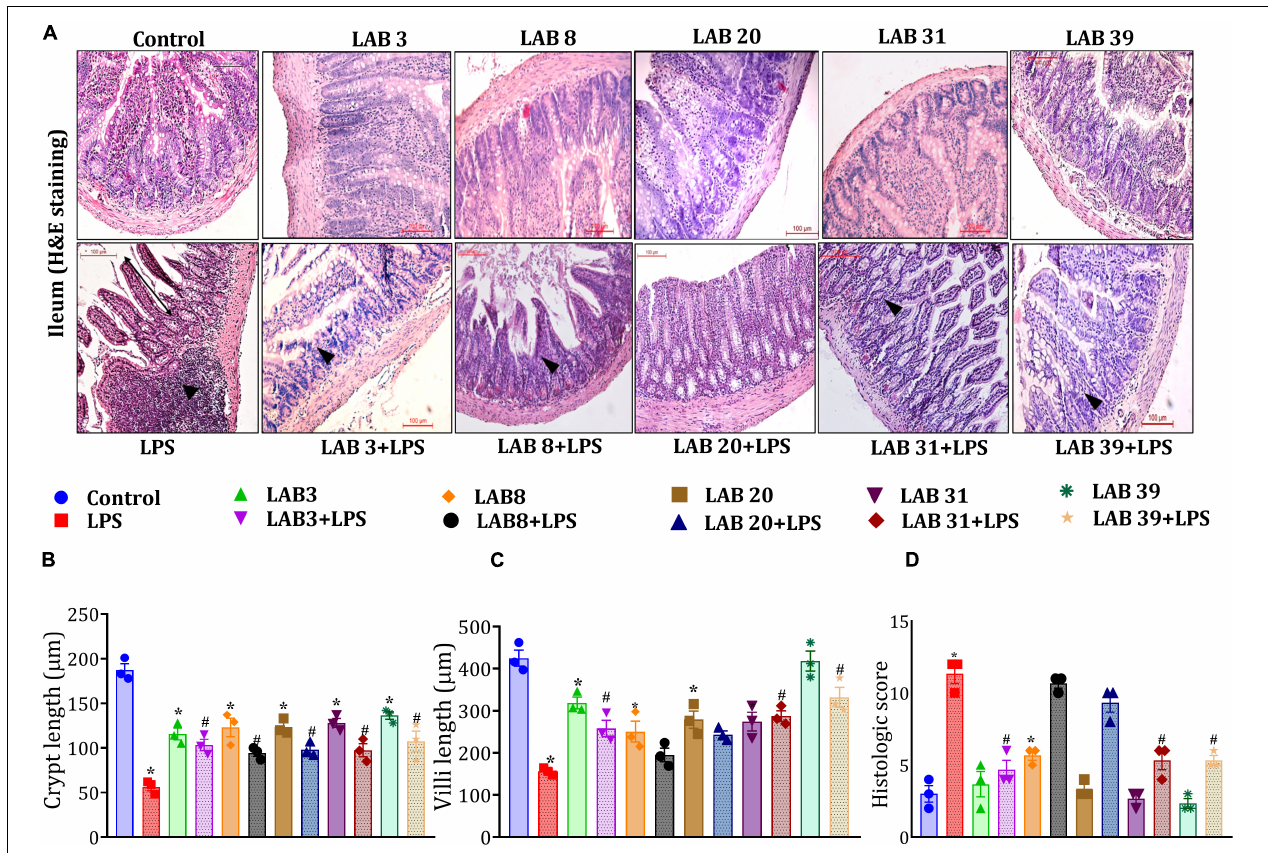
FIGURE 4 | Effect of LAB supplementation on the ileum architecture: (A) Hematoxylin–eosin staining images; (B) crypt length; (C) villi length; and (D) histologic score. Data were analyzed using one-way ANOVA with Tukey’s post hoc test ( p ≤ 0.05). *Significant relative to control; #significant relative to the LPS group ( N = 3); (arrows indicate the neutrophil infiltration; r : 200 µ m,